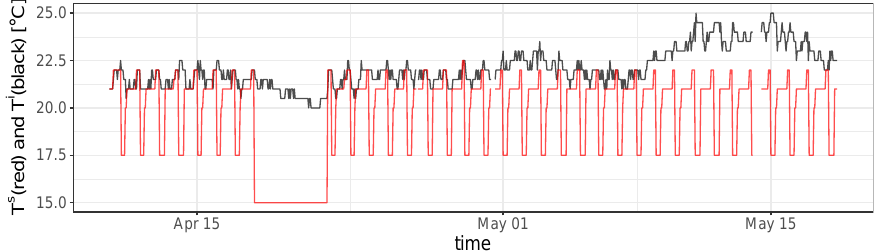
Figure 5. Input and output variables of the demand and supply-side models for one household.